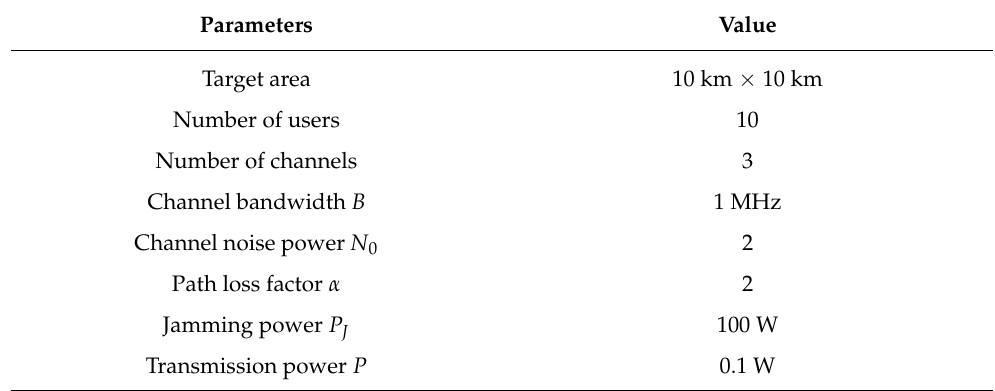
Table 2. Settings of model-related